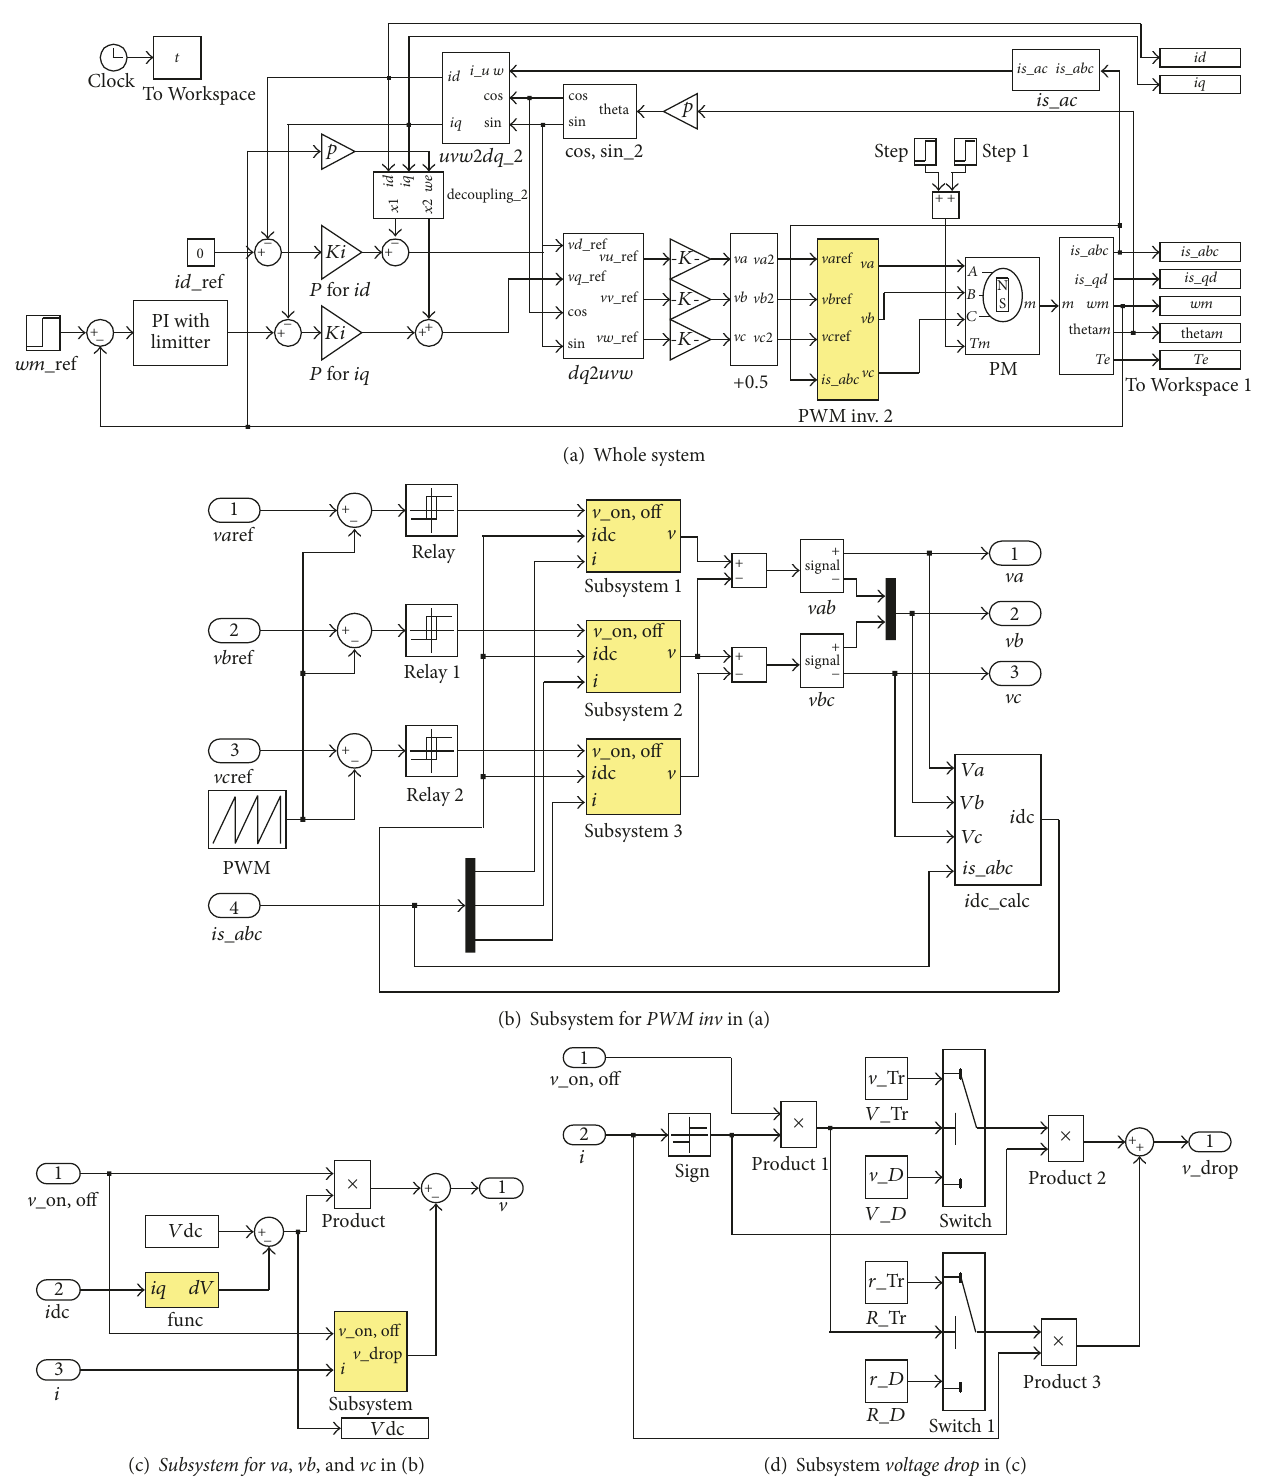
Figure 17: Block diagram for a brushless DC motor controlled using the vector control